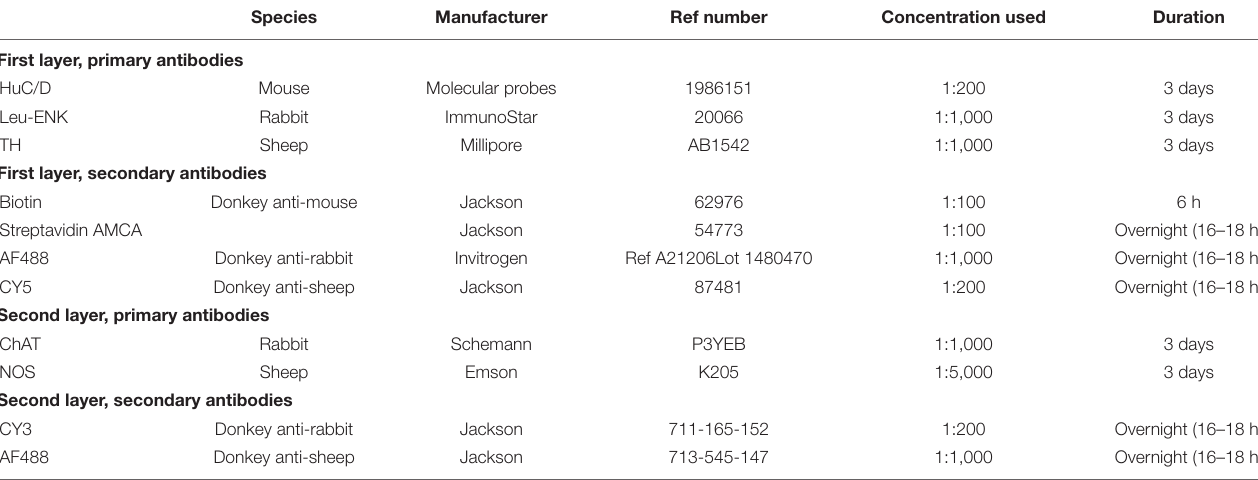
TABLE 1 | First and second layers of immunohistochemistry, primary and secondary antibodies.